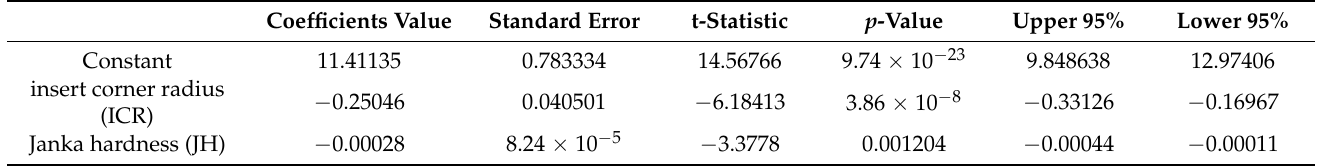
Table 5. The obtained results of the Janka hardness (JH) and insert corner radius (ICR) multiple linear regression